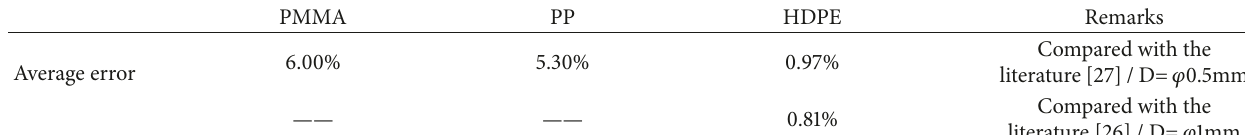
Table 5: Average error of SNNE model.